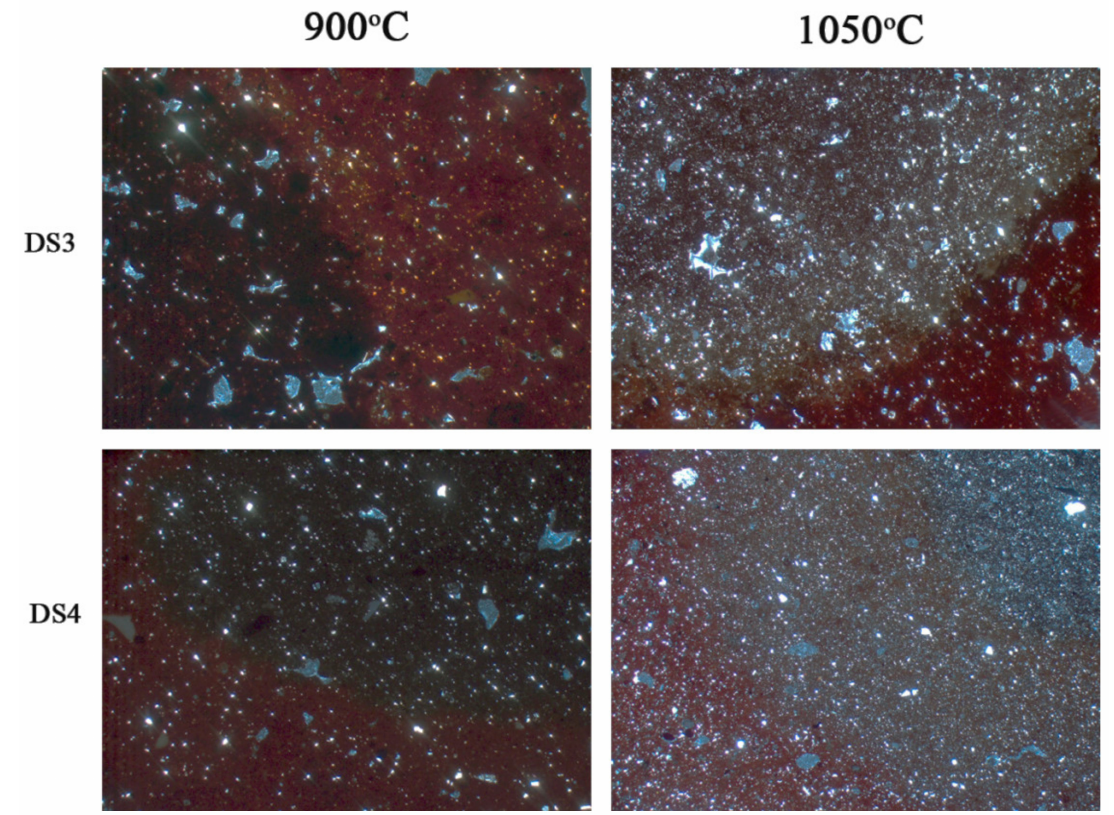
Figure 13. Photomicrographs of the thin sections made from the DS briquettes of the non-calcareous raw materials. All photomicrographs are taken under crossed Nicols (XP). (Width of field of view: 4.4